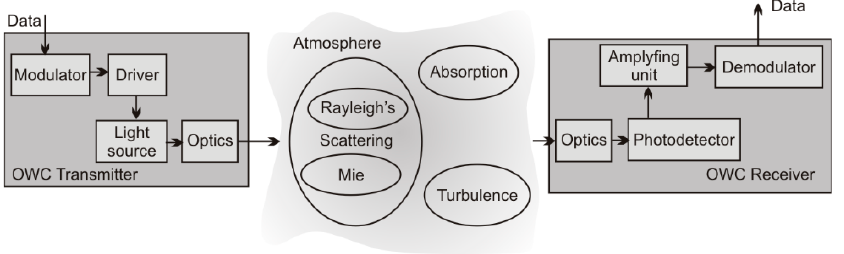
Figure 1. Block scheme of the OWC system.